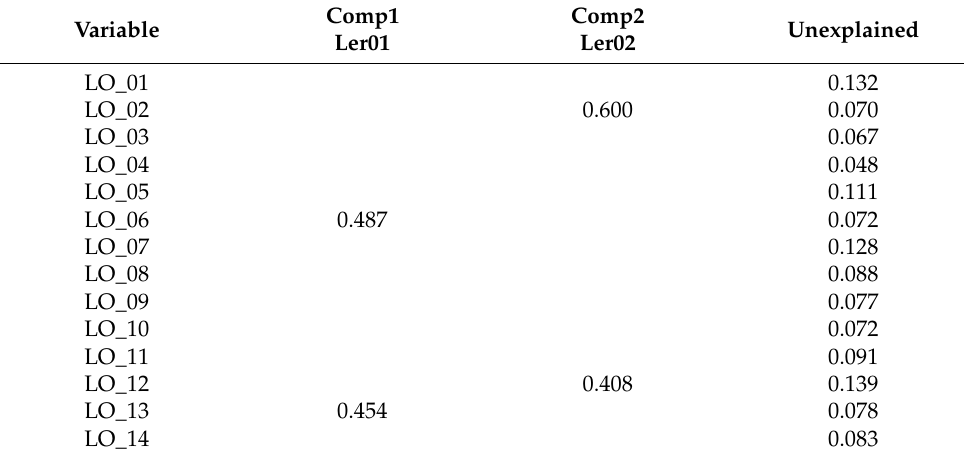
Table 19. Rotated component matrix—learning outcomes.